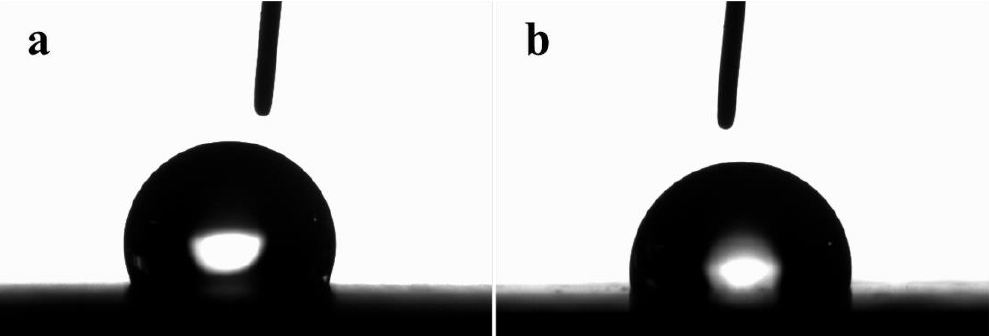
Figure 4. Images of water droplet (4 μL) on the surface of the modified nanoscale titania coating: ( a ) original coating, ( b ) coating after coupon corrosion test.